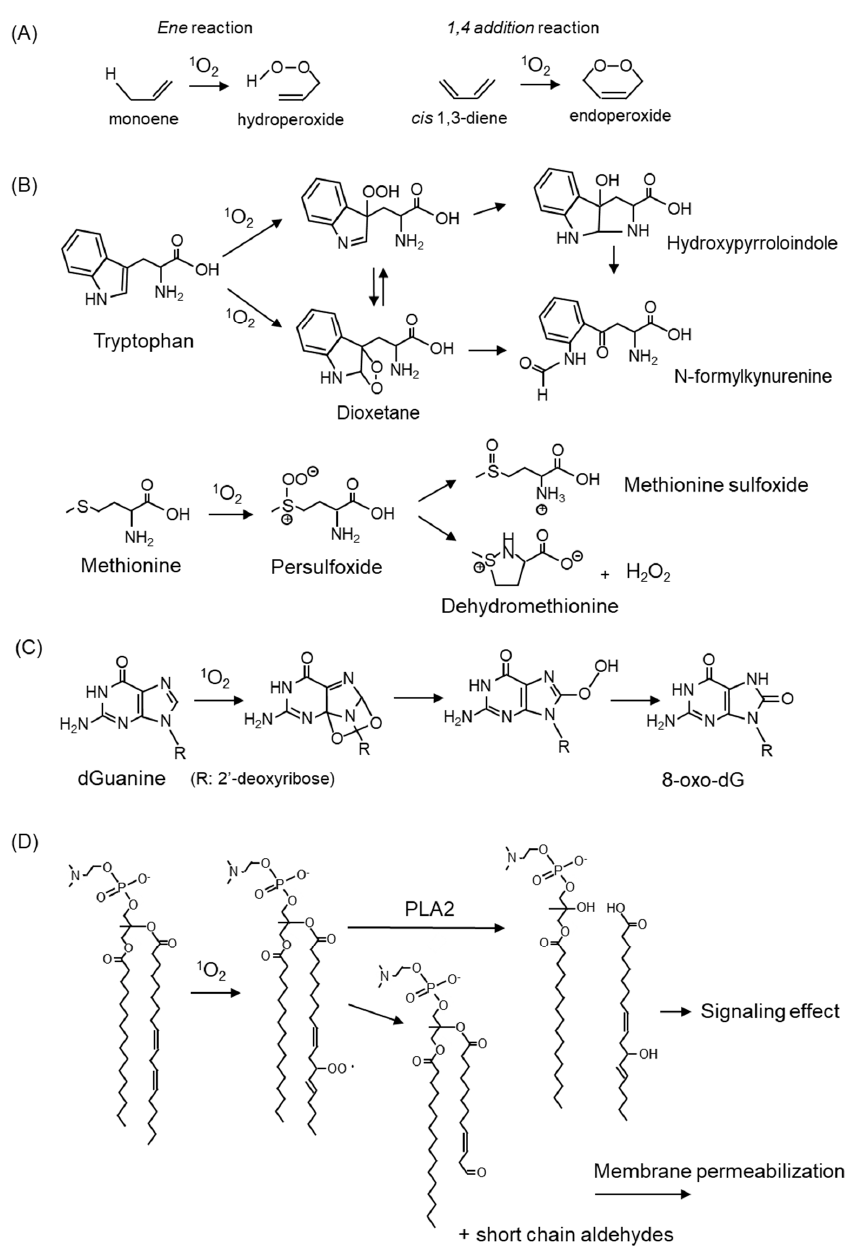
Figure 3. 1 O 2 -mediated oxidation of amino acid, nucleic acid, and lipids. ( A ) Oxygenation reaction by 1 O 2 . ( B ) Reaction products of tryptophan and methionine with 1 O 2 . ( C ) Formation of 8-oxo-2 ′ -deoxyguanosine (8-oxo-dG) by 1 O 2 oxidation to deoxyguanosine (dG). ( D ) Oxidative modification of fatty acids in membrane phospholipids by 1 O 2 . Amino acids, which are components of proteins, are the targets of 1 O 2 . Among the 20 natural amino acids, tryptophan, histidine, tyrosine, and the sulfur-containing amino ac- ids cysteine and methionine, are susceptible to reaction with 1 O 2 because of their structural properties. The reaction products of tryptophan and methionine with 1 O 2 are shown in Figure 3B. Tryptophan reacts with 1 O 2 to form a hydroperoxide at the C3 position as an